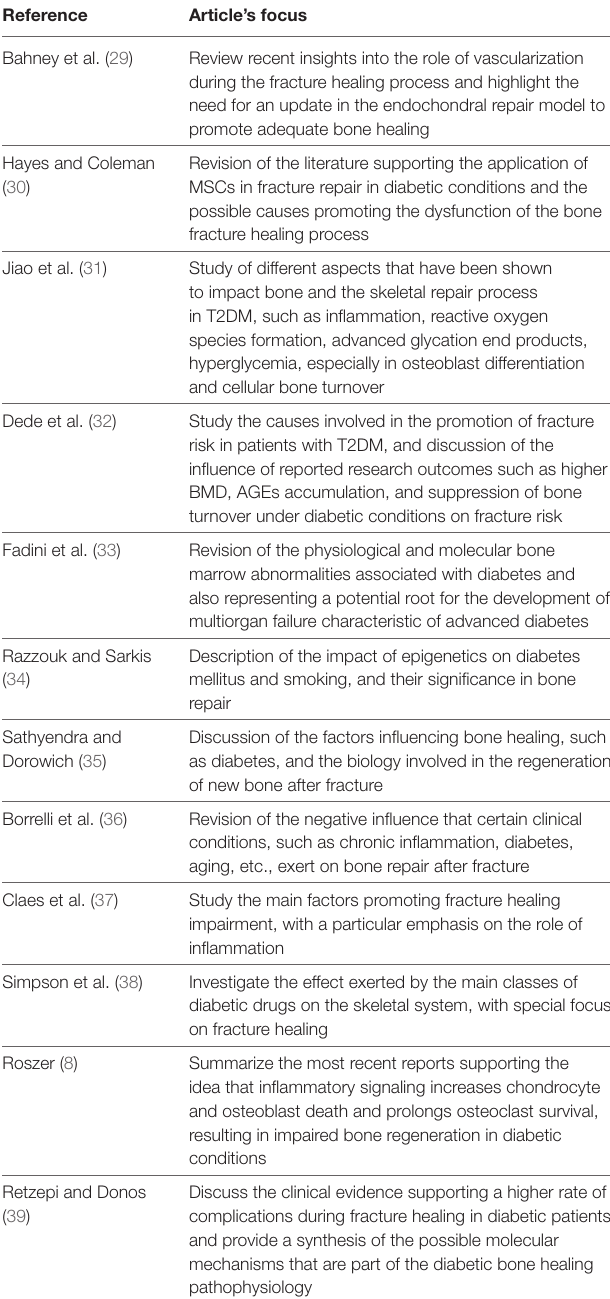
TaBle 4 | Review articles on bone healing in type 2 diabetes mellitus (T2DM) published between January 2007 and March 2017 (in descending